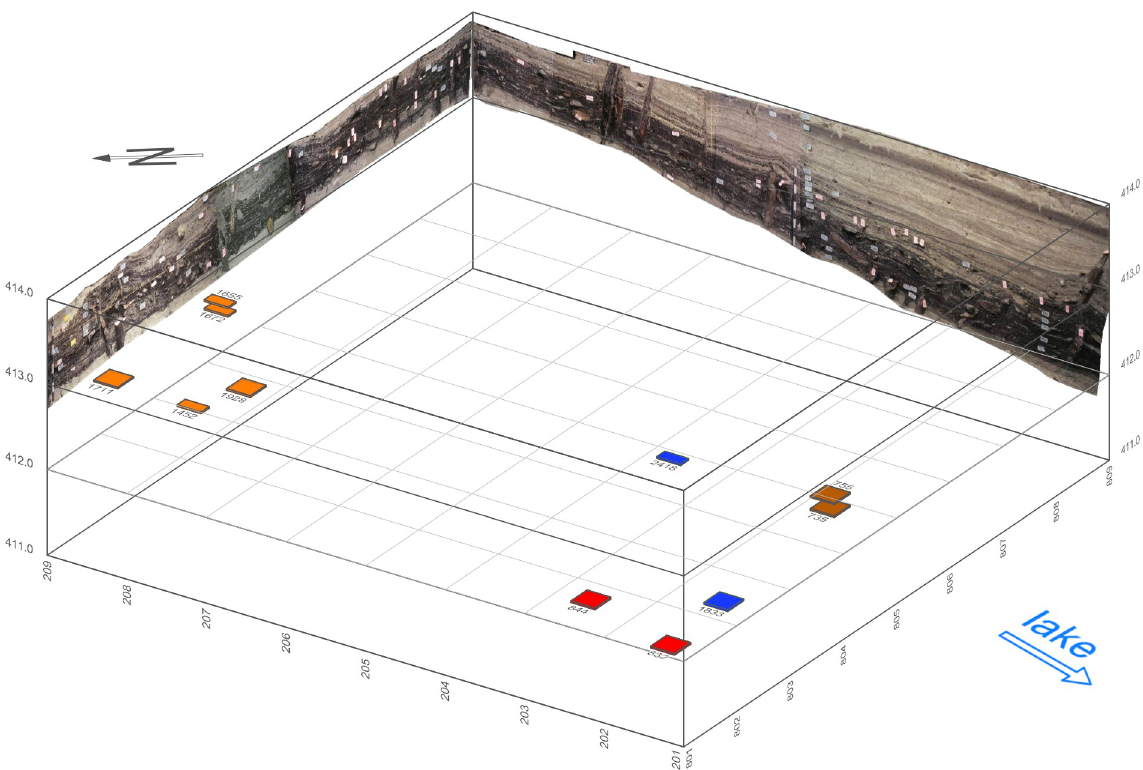
Fig 6. Position of the 11 bulk samples collected at Zug-Riedmatt ( © ADA Zug). Samples from unit 3 in blue, unit 5 in orange, unit 6 in red and unit 8 in brown. Easting, northing and elevation values are given in metres.